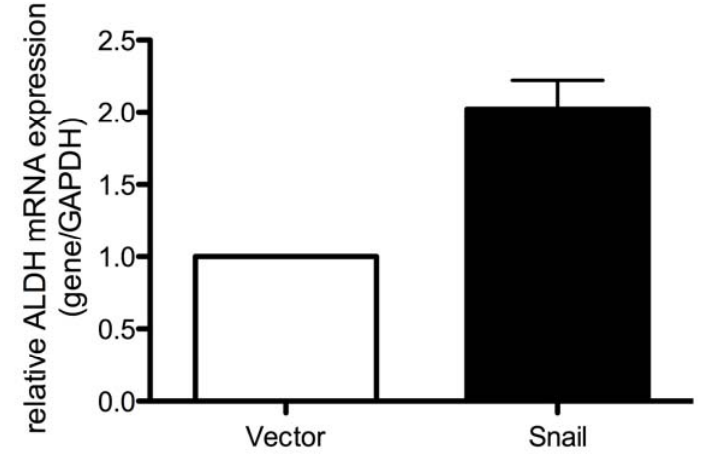
Figure 3. Expression of the stem cell marker aldehyde dehydrogenase is associated with increased expression of Snail. Graph showing a comparison of aldehyde dehydrogenase (ALDH) expression, as measured by qRT-PCR, normalized to GAPDH, in CD-18 pancreatic cancer cells induced to express either Snail or a control